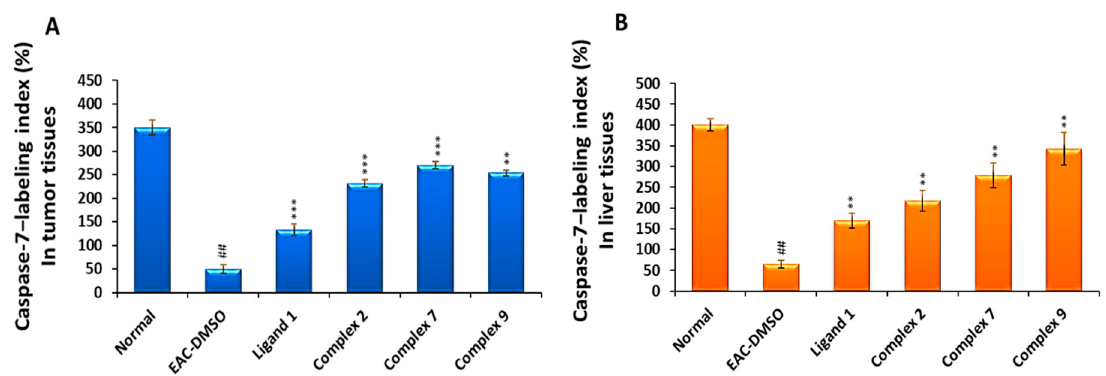
Figure 3. E ff ect of ligand 1 and its metal complexes 2 , 7 and 9 on cysteine aspartyl-specific protease-7 (caspase-7) expression in tumor tissues ( A ) and in liver tissues ( B ) of Ehrlich ascites carcinoma (EAC)-bearing mice. Caspase-7 expression was determined by immunohistochemistry assay. Caspase-7 expression was expressed as labeling index percentage. Data are expressed as mean ± SEM. Significantly ( ## p < 0.01) di ff erent from the normal mice and significantly (** p < 0.01 and *** p < 0.001) di ff erent from mice bearing solid tumor treated with vehicle